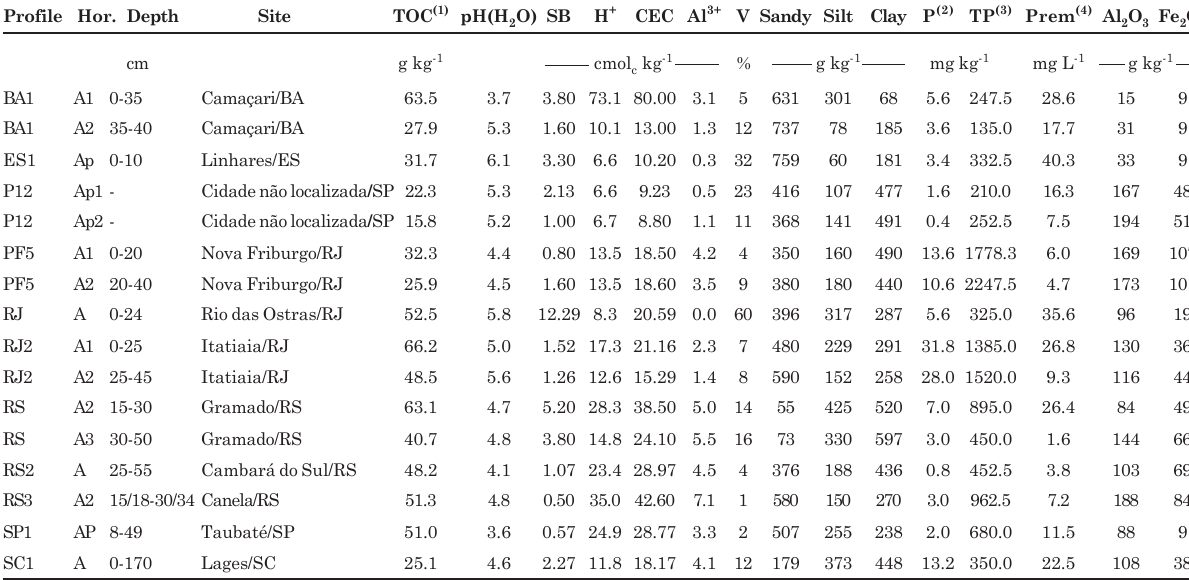
Table 3. General, morphological, chemical, and particle size characteristics of Humic A surface horizon